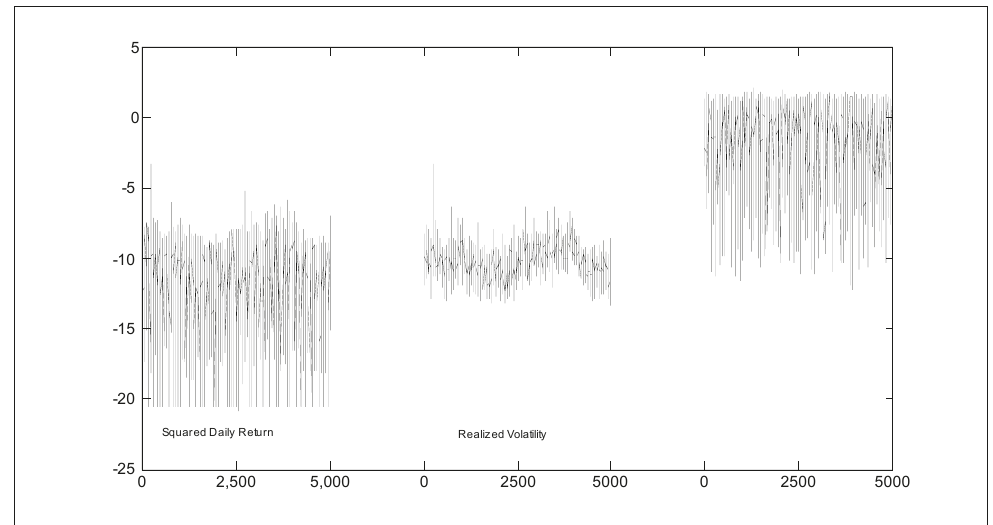
Figure 3. Log squared daily returns (left), log realized volatility obtained from 1-minute returns (middle) and the di (cid:30) erence (right) for the high-frequency S&P 500 returns data. The sample period is from October 7, 1986 to March 2, 2007.